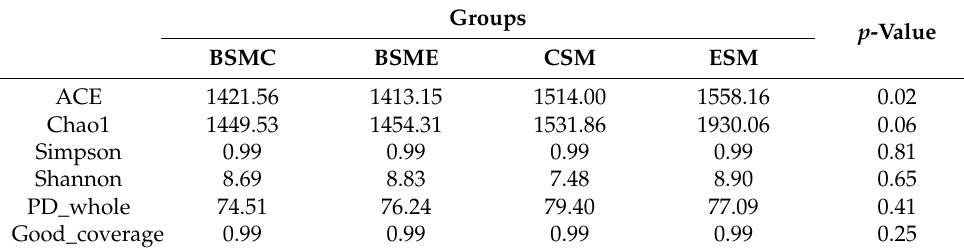
Note: BSMC: soil microorganisms in the counterpart group before the experiment; BSME: soil microorganisms in the experimental group before the experiment; CSM: soil microorganisms in the counterpart group after the experiment; ESM: soil microorganisms in the experimental group after the experiment ( n =